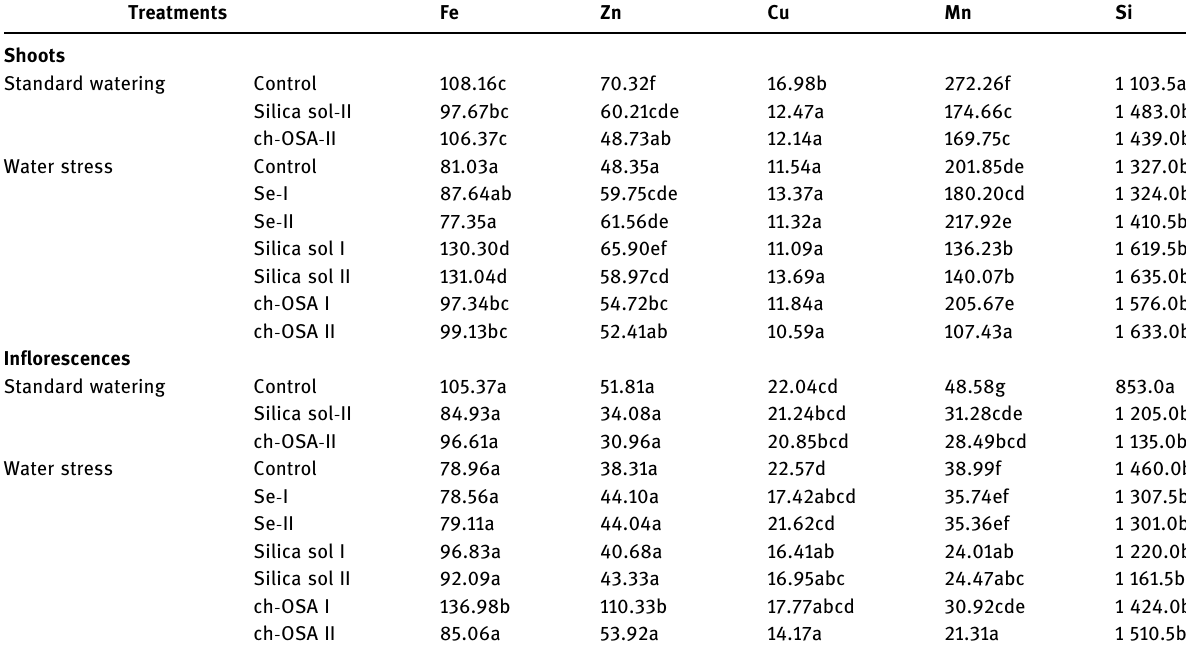
Table 7: The in fl uence of the factors under study on the content of microelement and silicon in shoots and in fl orescences of Tagetes patula L. “ Pascal ” ( in mg kg − 1 of D.M. )